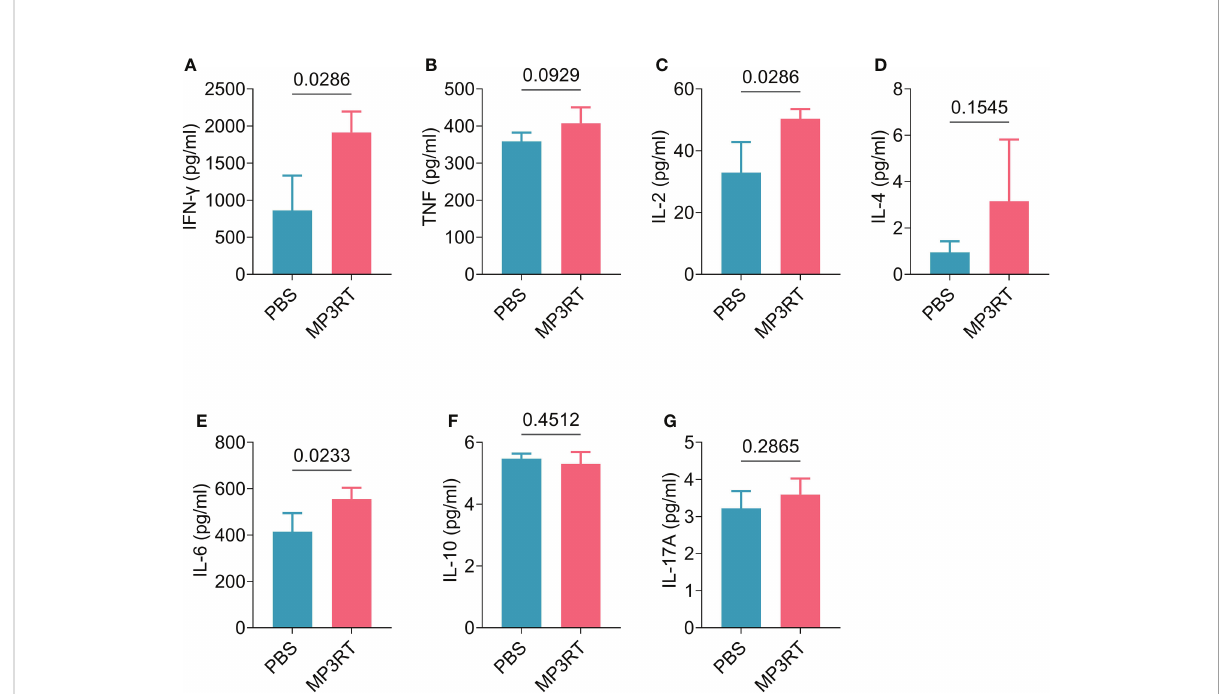
FIGURE 11 The levels of cytokines induced by the MP3RT vaccine in mice. The levels of IFN- g (A) , TNF- a (B) , IL-2 (C) , IL-4 (D) , IL-6 (E) , IL-10 (F) , and IL-17A (G) cytokines induced by the MP3RT vaccine in the PBS group and MP3RT group were detected by a Mouse Th1/Th2/Th17 Cytokine Kit. In order to reduce individual differences, the spleens of mice in each group were mixed to prepare spleen cell suspensions, and then cytokine detection were performed in quadruplicate. The results were analyzed with the Unpaired t-test or Mann-Whitney test according to the normality. All data were shown as mean + SEM ( n = 4). P < 0.05 was considered signi fi cantly